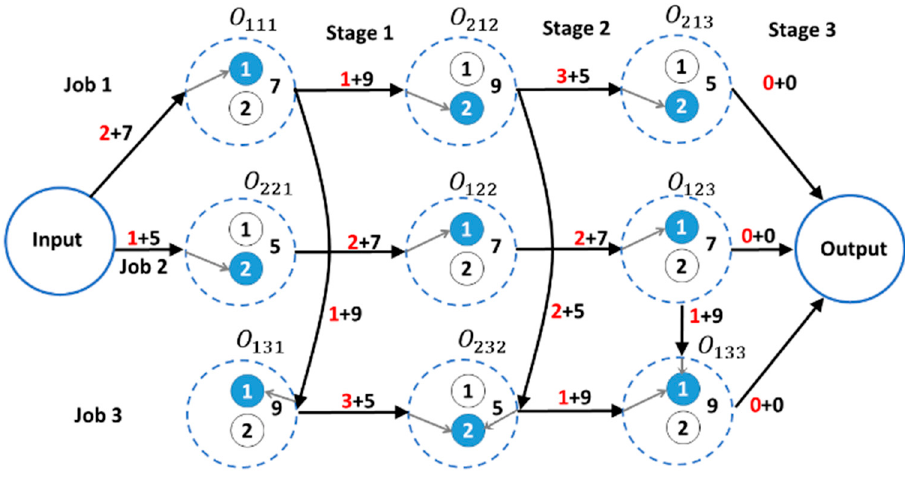
Figure 2. One solution for the RFFSP with three jobs, three stages, and two machines by stage. A Gantt diagram of the scheduling of the solution described previously is shown in Figure 3, where the job’s operations are outlined using the same color. In this diagram, the solution fulfills the precedence constraints between pairs of operations of the same job, and each operation starts its processing until the machine setup time is accomplished. The solution of any RFFSP instance can be reached using the mathematical model described in the previous section.